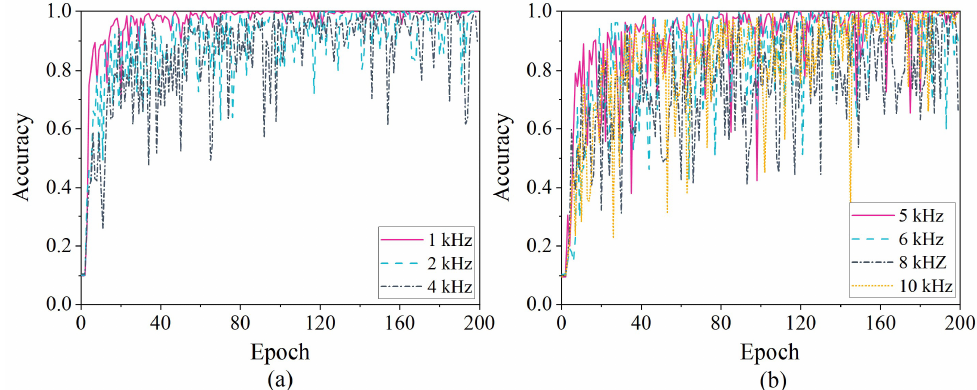
Figure 18. The validation accuracy of dataset B, ( a ) 1 kHz, 2 kHz, 4 kHz, ( b ) 5 kHz, 6 kHz, 8 kHz, and 10 kHz.